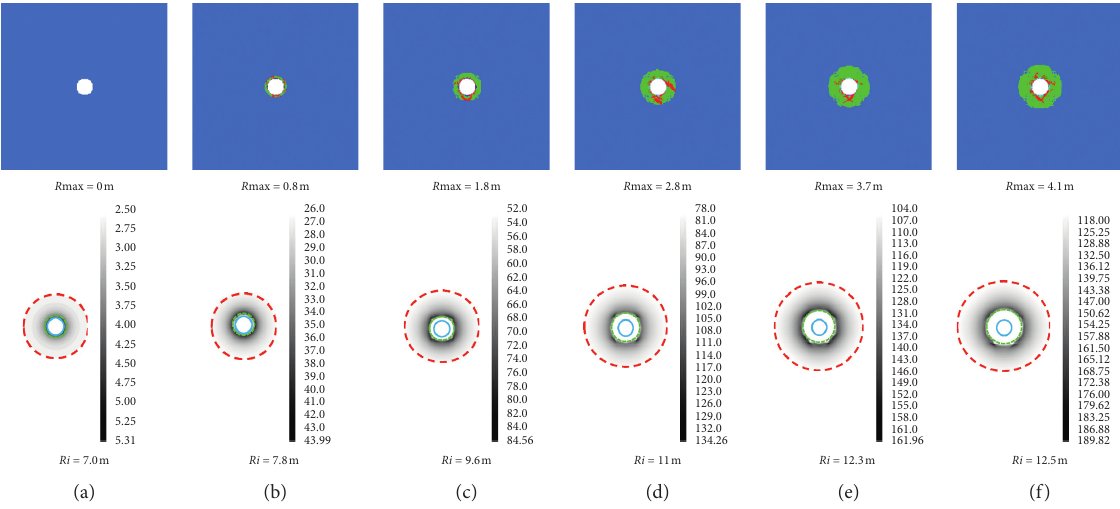
Figure 3: Plastic area of the surrounding rock of the hole in the mudstone and its influence range: (a) H � 100m; (b) H � 1000m; (c) H � 2000m; (d) H � 3000m; (e) H � 4000m; (f) H � 4500m.